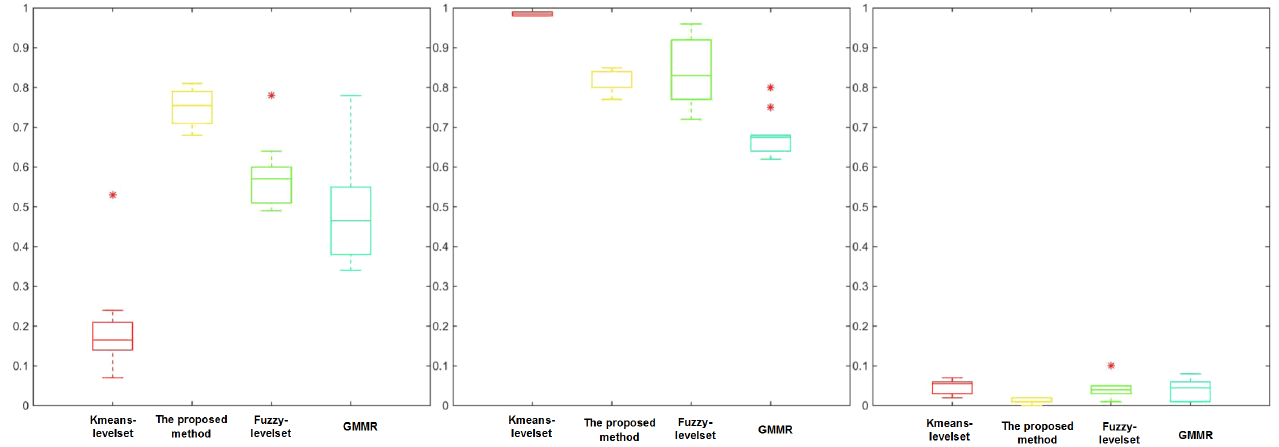
Fig. 10. Comparison of four algorithms with three evaluation methods. The red box indicates the comparison between manual and K -means – level-set. The yellow box stands for the proposed method. The green is for the FCM – level-set. The blue is for the GMMR.